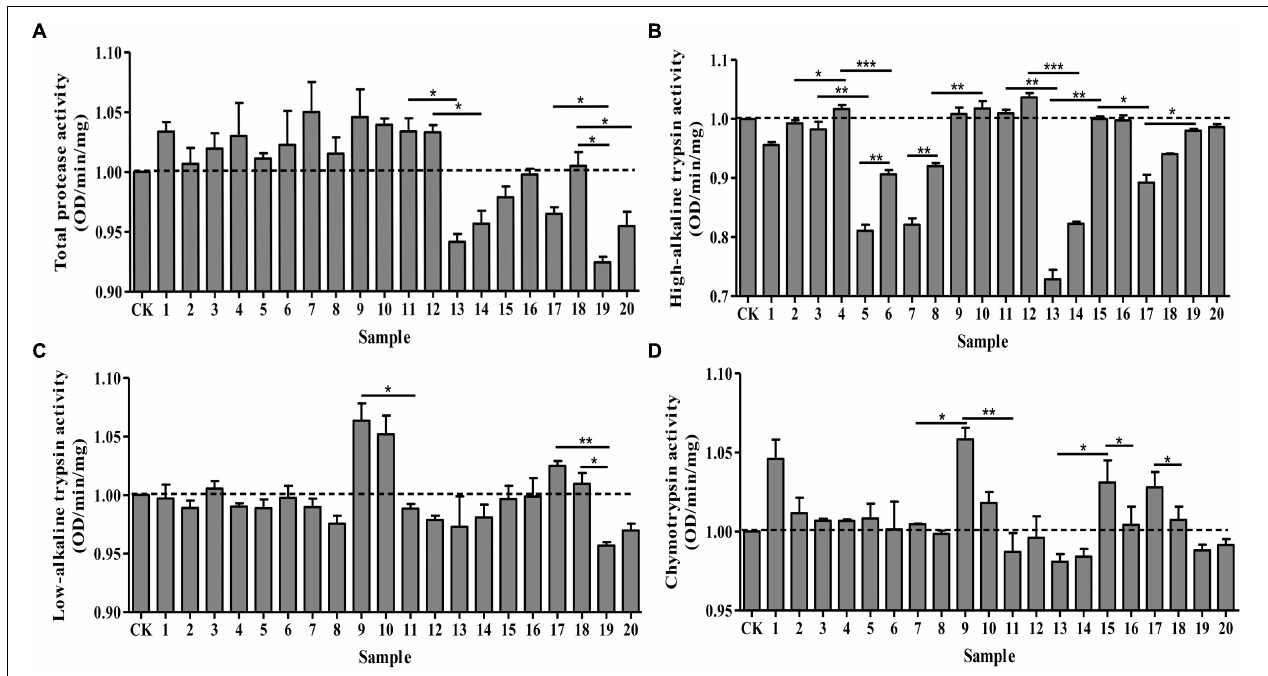
FIGURE 1 | Effects of protease activators and inhibitors on the activity of proteases in Plutella xylostella larvae. (A) Total protease. (B) High-alkaline trypsin. (C) Low-alkaline trypsin. (D) Chymotrypsin. The dotted line indicates the control group. Columns represent means of three independent values and their SEM.